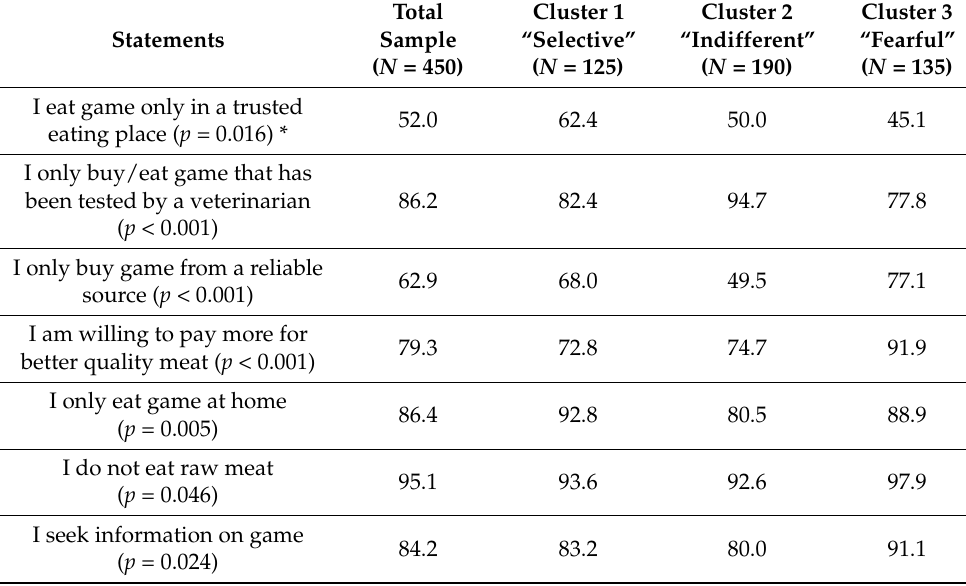
Table 4. Cluster profiles according to the participants’ buying and eating behavior that ensure safety and mitigate health risks ( N = 450, Poland).